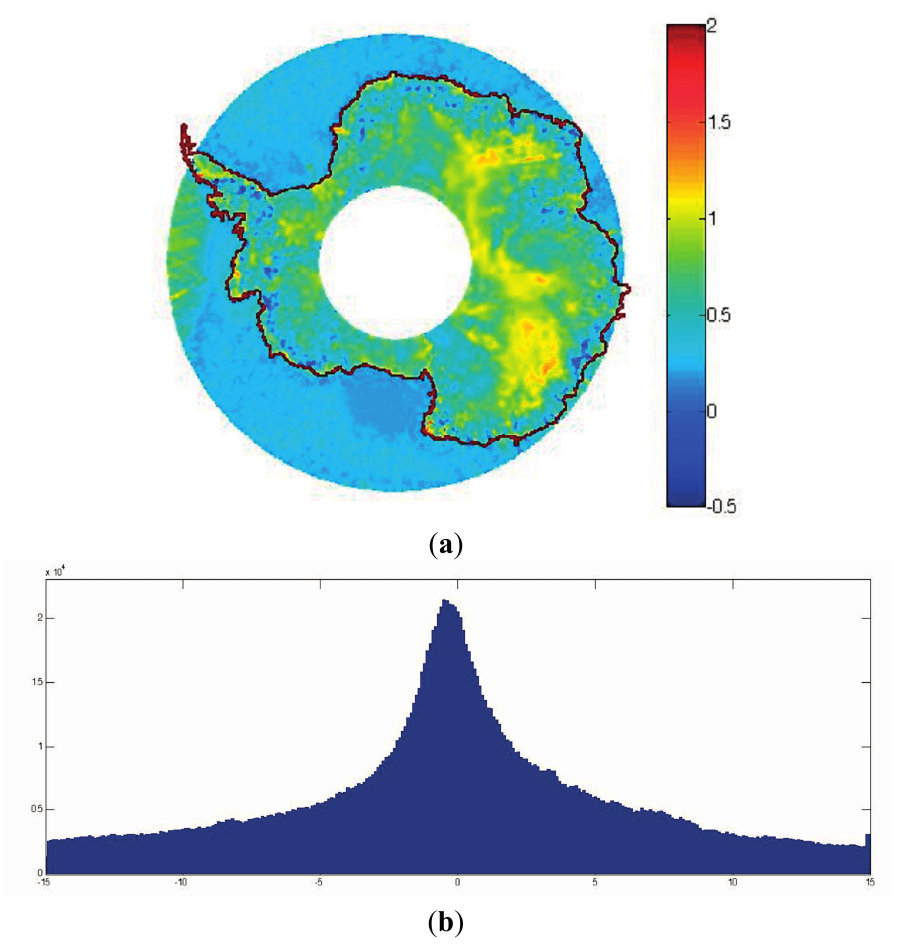
Figure 9. ( a , b ) Elevation difference in meters between the Ice-1 algorithm and the Ice-2 algorithm for the 72nd cycle from ENVISAT (a), distribution of the elevation difference in meters between ICESat and ENVISAT derived from the Ice-1 retracking algorithm (b).